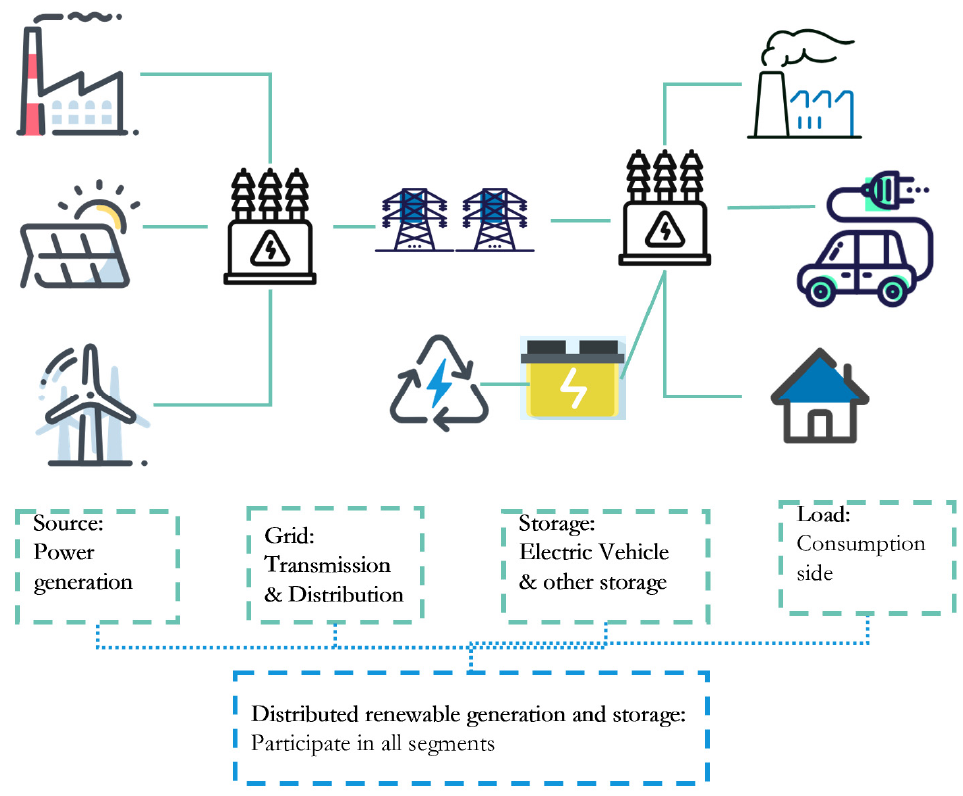
Figure 3. Life cycle process for the grid system.